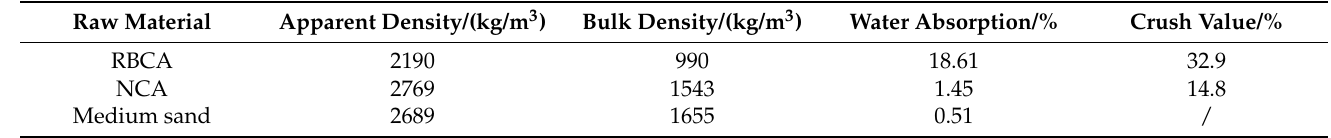
Table 1. Physical properties of